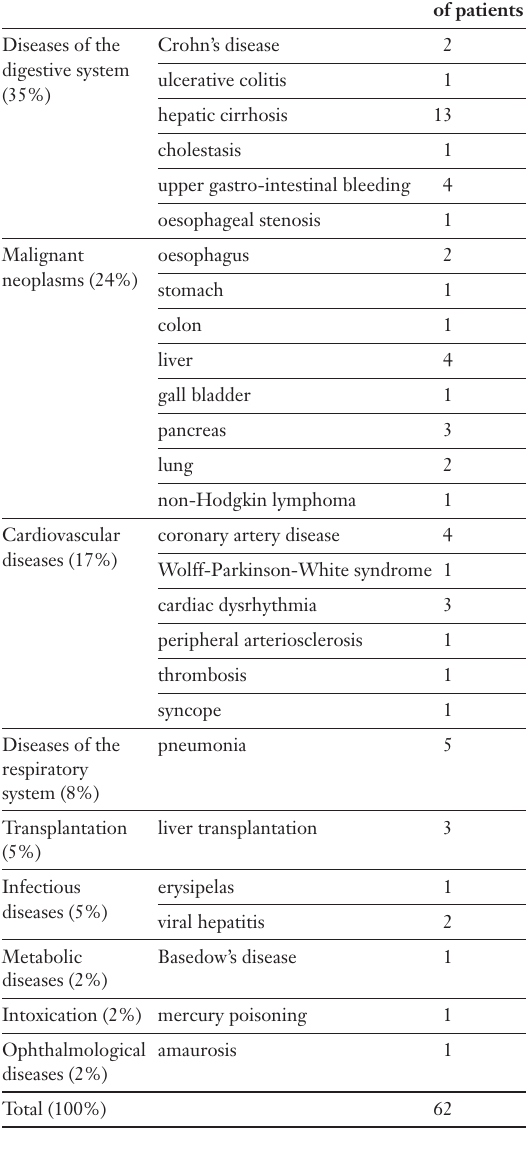
Main somatic diag- noses based on ICD 9 of the patient popula- tion (n = 62).